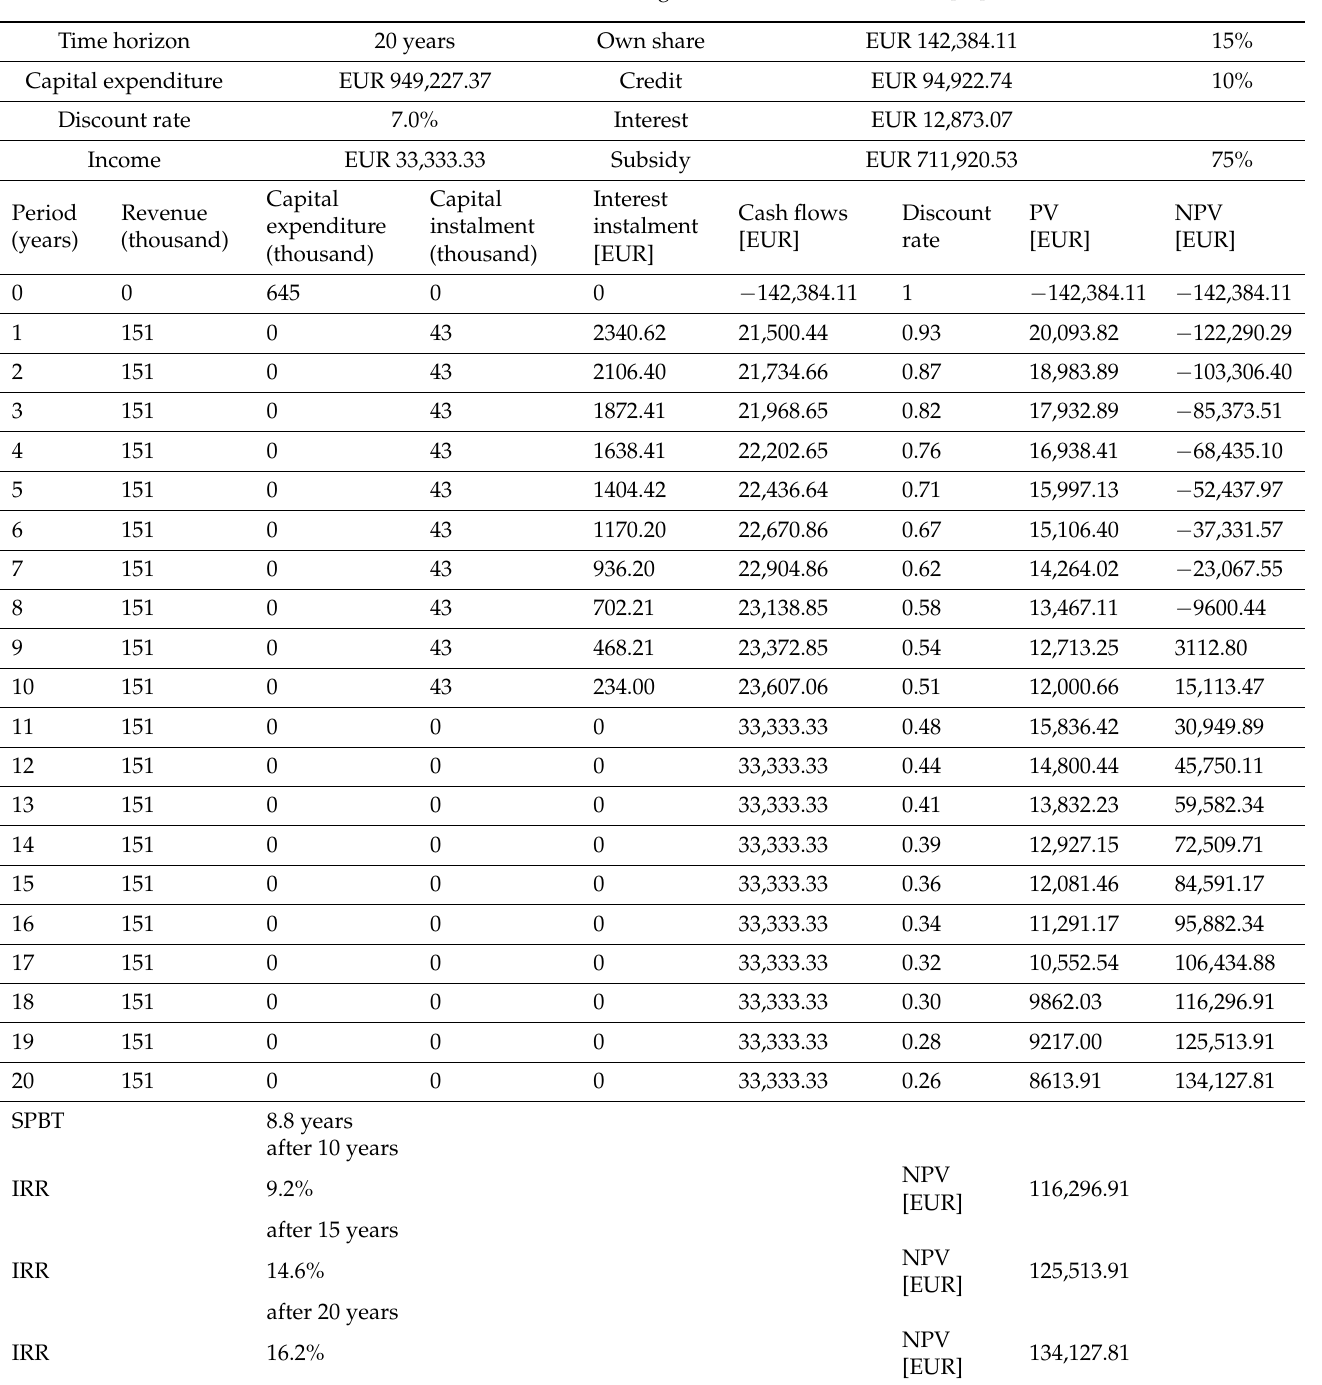
Table 5. Economic indicator for biogas investment in Pawł ó wko